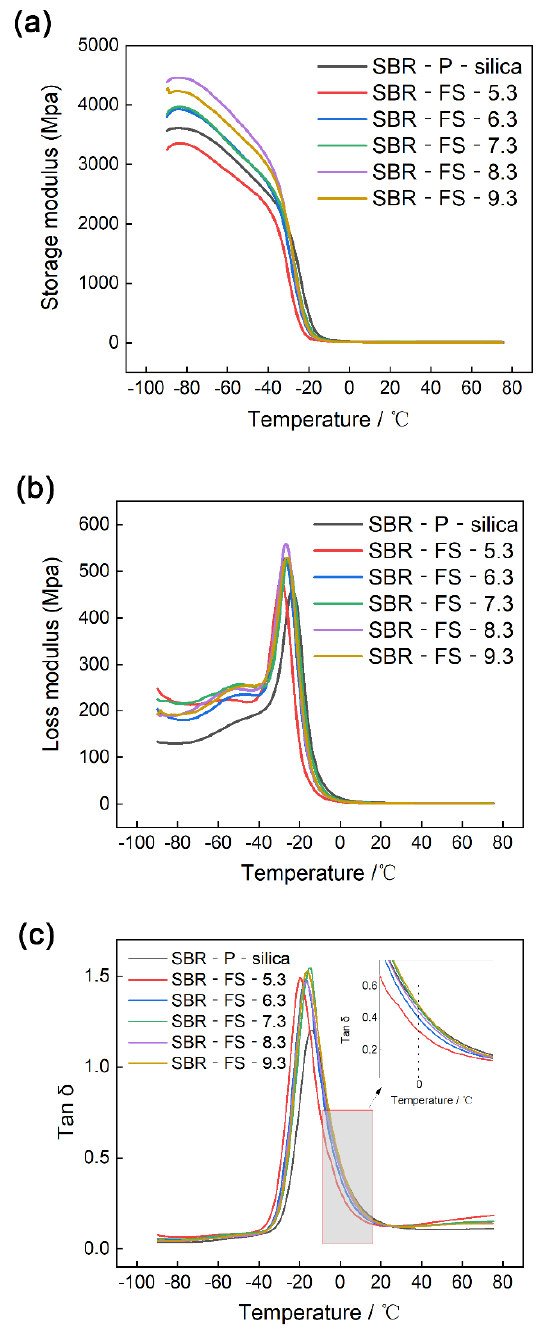
Figure 9. Storage modulus ( a ), loss modulus ( b ), and tan δ ( c ) as functions of temperature of the SBR vulcanizates filled with P-silica and FS-SiO 2 (the insert is a magnification of the temperature, around 0 °C).